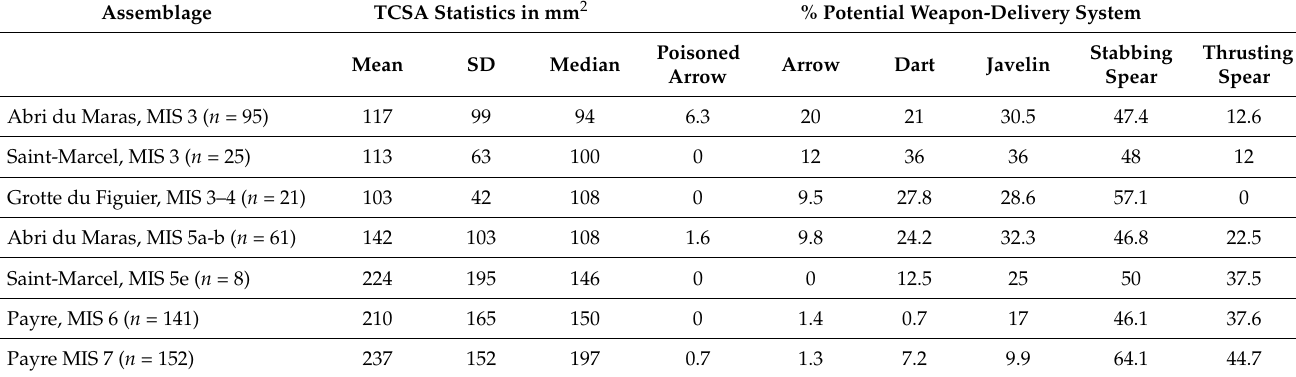
Table 2. TCSA statistics (values in mm 2 ) and percentage frequencies of potential weapon-delivery systems based on our